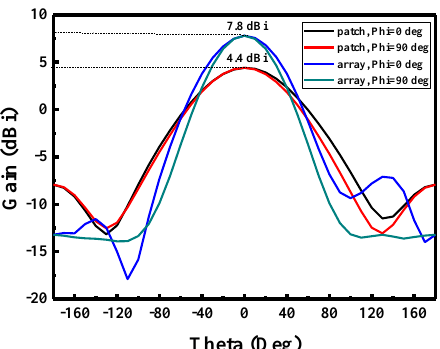
Figure 7. The gains of the single patch antenna and the patch antenna array.